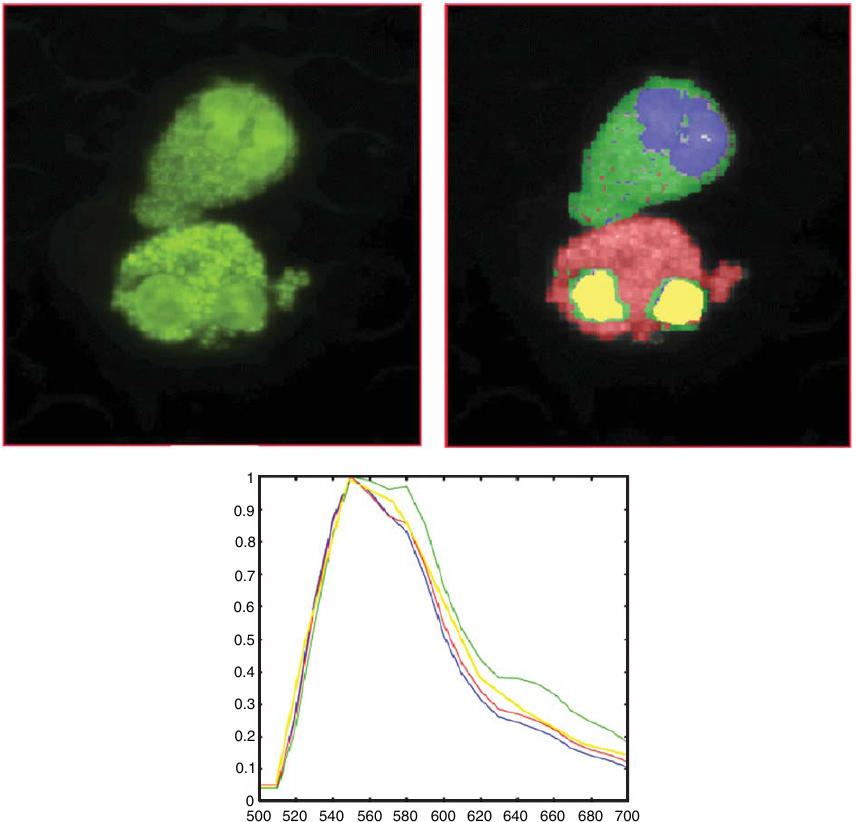
Fig. 7. Spectral classification of subcellular compartments in immature blood